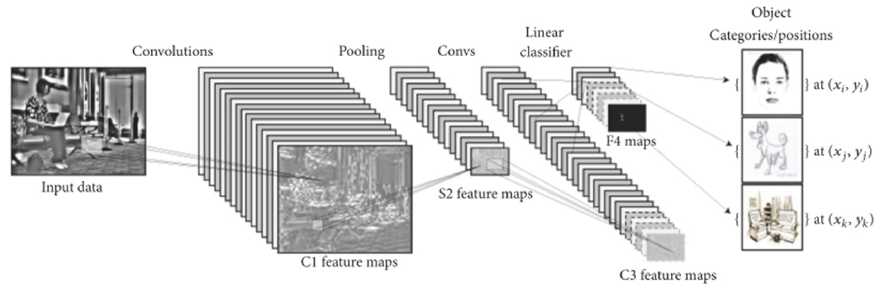
Figure 1. Example architecture of a CNN for an object detection task [36].